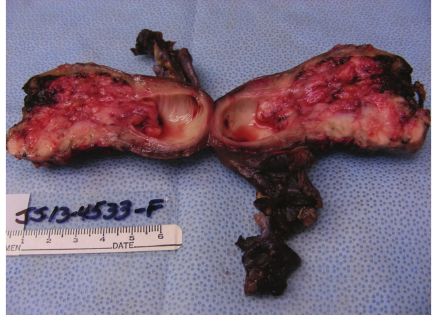
Figure 5: Hysterectomy specimen showing replacement of lower uterine segment and cervix with papillary serous